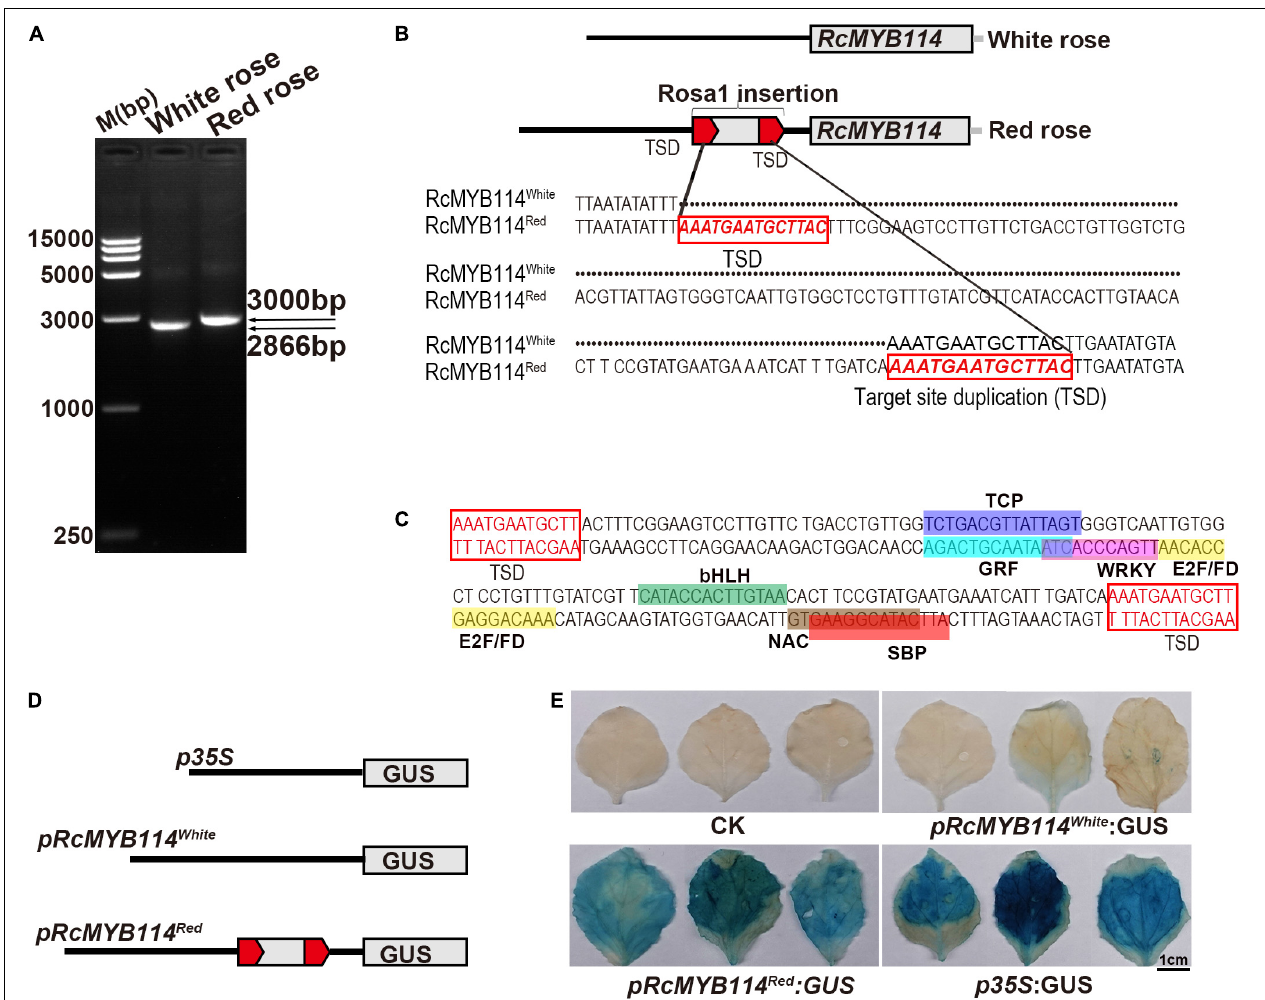
FIGURE 3 | Confirmation that the Rosa1 transposable element-like sequence inserted into the promoter region of RcMYB114 alters its expression. (A) Promoters, pRcMYB114 Red and pRcMYB114 White , were cloned by PCR amplification. (B) Sequence analysis of Rosa1, a transposable element-like sequence in the promoter of RcMYB114 Red . Red frame and letters indicate the target site duplication (TSD) and sequence. (C) Domain analysis of the Rosa1 transposable element-like sequence. (D) Schematic diagram of the pRcMYB114 Red and pRcMYB114 White promoter- β -Glucuronidase ( GUS ) fusion vectors. The RcMYB114 promoters replaced the CaMV35S promoter in pBI121. (E) Histochemical assay of GUS activity in N. benthamiana leaves after being infiltrated with the p35S:GUS , pRcMYB114 Red :GUS , and pRcMYB114 White :GUS